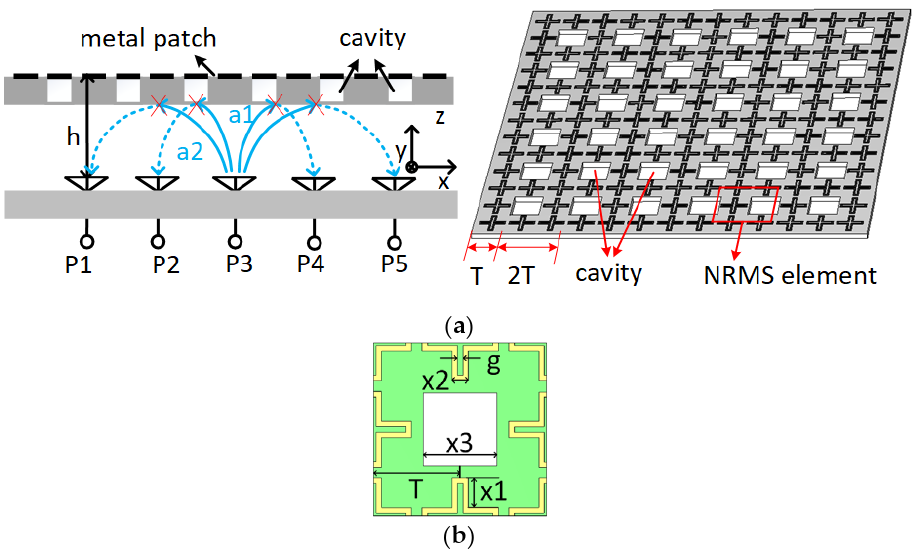
Figure 1. ( a ) the decoupling principle of the NRMS for the large-scale antenna array, ( b ) the detailed structure and dimensions of the unit cell to implement the NRMS.